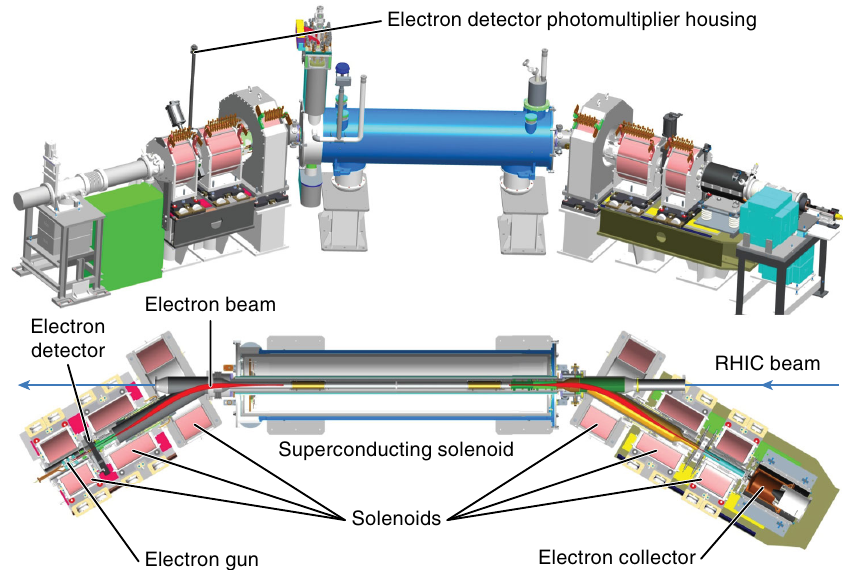
FIG. 3. Perspective and top views of one of the RHIC electron lenses [11,12], showing the backscattered electron detector location close to the electron gun. In reality, the light guide and photomultiplier tube are enclosed in a heavy and light-tight magnetic shield to protect the PMT from the stray fields of the nearby magnets.